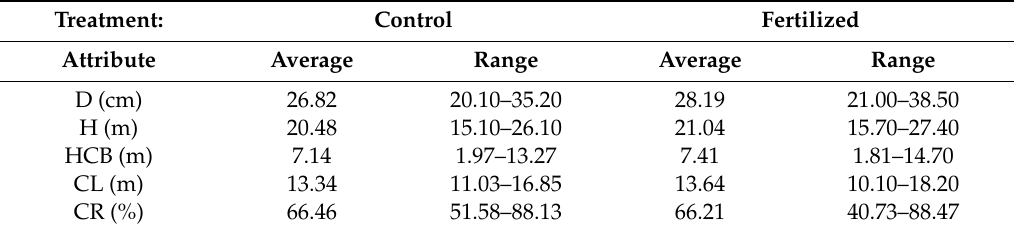
Table 1. Average and range of diameter at breast height (D), total height (H), height-to-crown base (HCB), crown length (CL), and crown ratio (CR) for the 20 sample trees felled for each